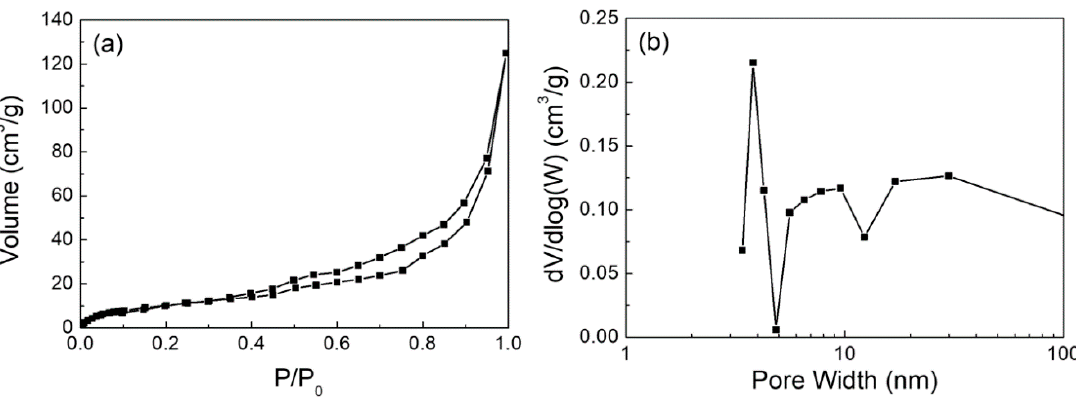
Table 4. BET results of Ca(OH) 2 nanoparticles.